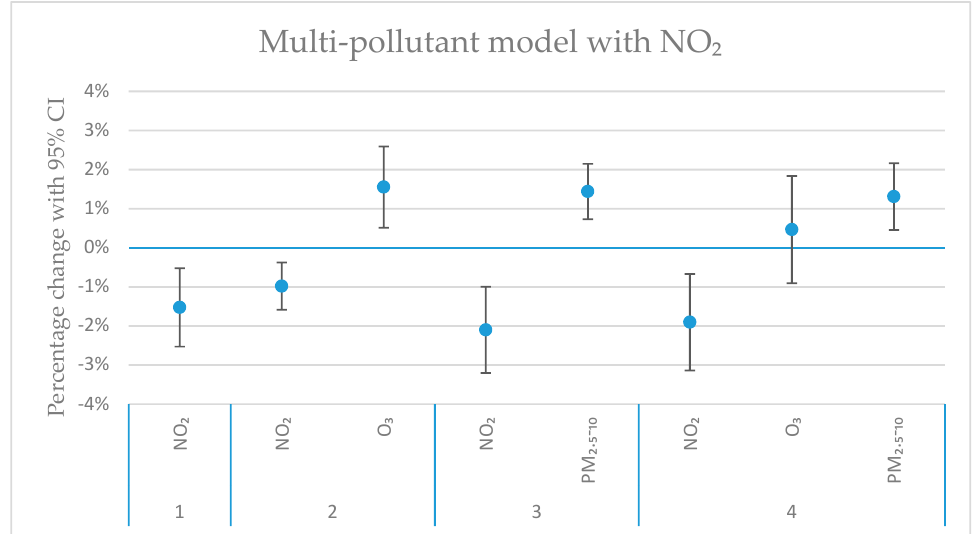
Figure 7. The estimated change in daily mortality (with 95% CI) for an IQR increase in concentration (lag02) of NO 2 , O 3 and PM 2.5–10 in a multi-pollutant model. Model 1 (furthest to the left) represents the single-pollutant estimate of NO 2 . Model 2 and 3 represent two-pollutant models, with O 3 (Model 2), and with PM 2.5–10 (Model 3). In Model 4, both NO 2 , O 3 and PM 2.5–10 are included.